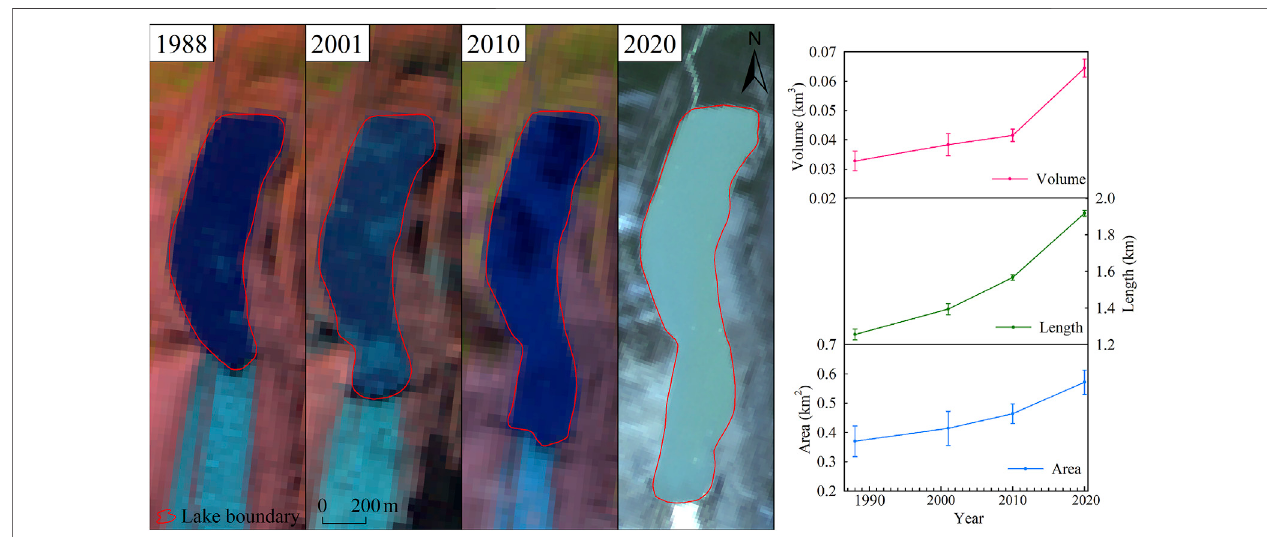
FIGURE5| Changesinthearea,length,andvolumeoftheJGLin1988 – 2020.BackgroundsaretheLandsatTMimage(Bands5,4,3)acquiredon9October1988 and 30 November 2001, Landsat ETM + image (Bands 5, 4, 3) acquired on 28 September 2010, and GF1_WFV4 image acquired on 24 June 2020 respectively.